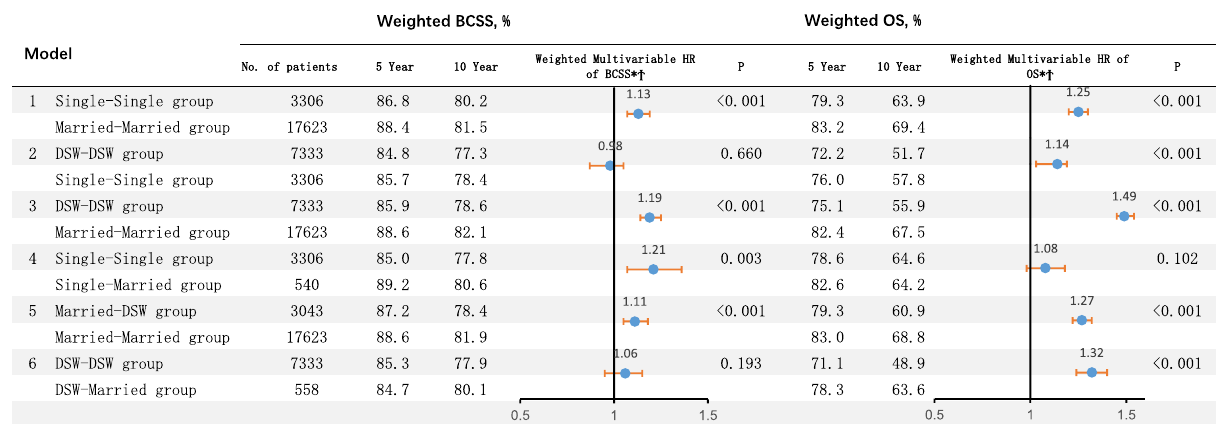
Figure 2. Hazard ratio comparing BCSS and OS according to marital status. (*) Weighted by inverse propensity score. ( Ϯ ) Multivariate analysis adjusted by year of diagnosis, age, race, year of diagnosis, insurance, histology type, nuclear grade, T stage, N stage, M stage, ER status, PR status, surgery, chemotherapy and radiotherapy. BCSS breast cancer-caused special survival, OS overall survival, HR hazard ratio, DSW divorced/separated/